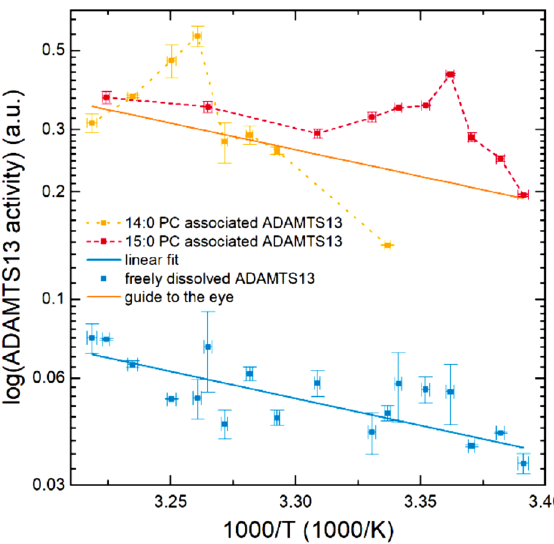
Figure 3. Arrhenius plots of the data shown in Fig. 1. The plot does not show kinks or discontinuities, but peaks at the phase transition temperature for the membrane associated